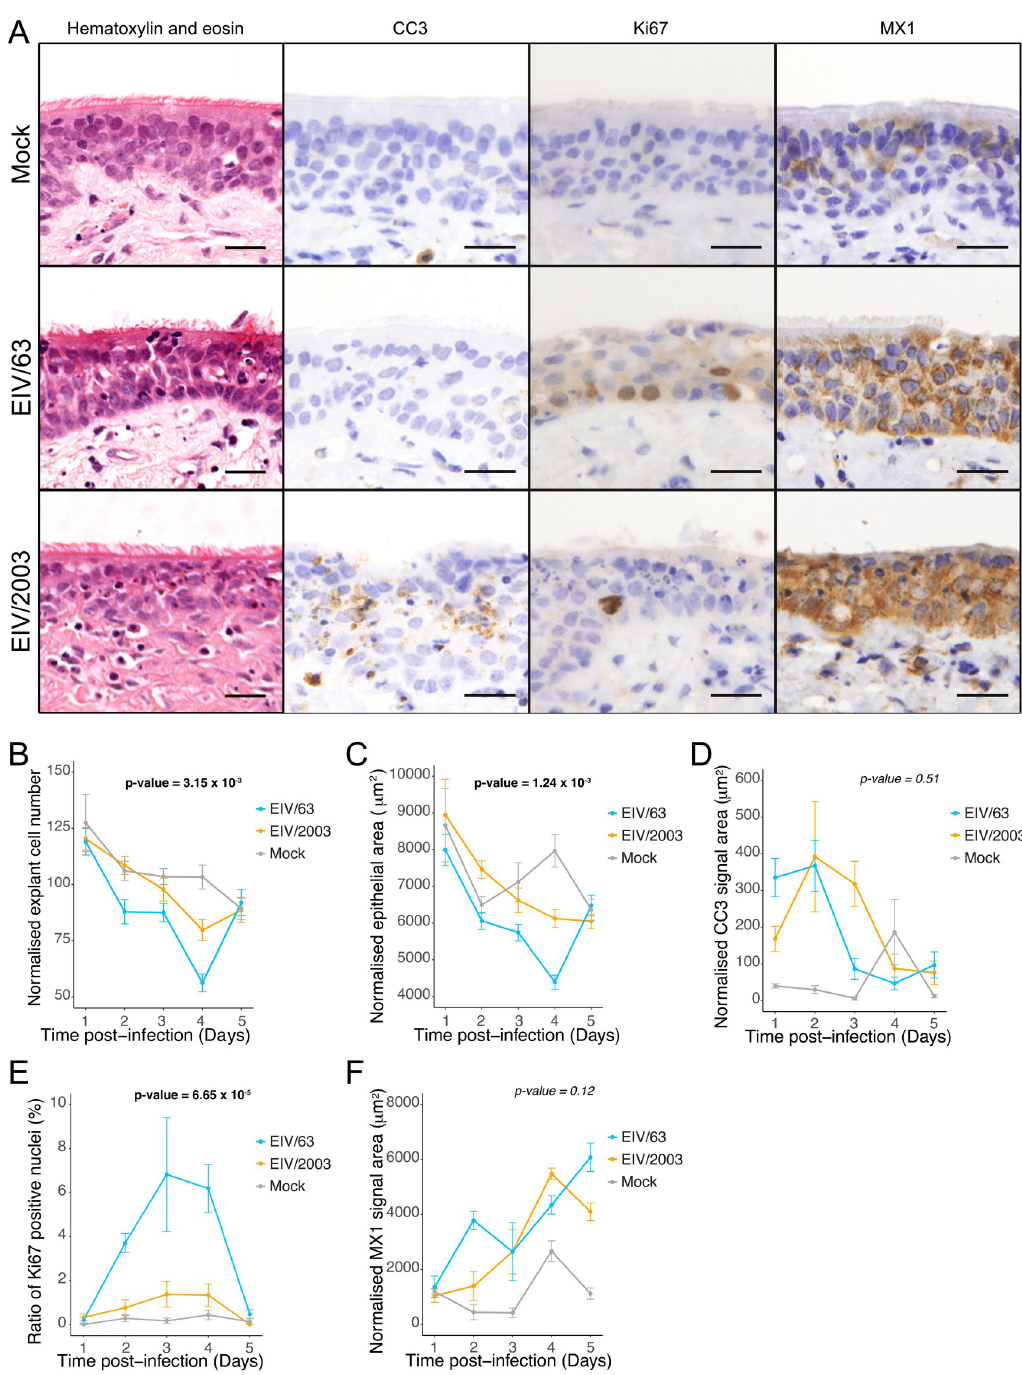
Fig 7. Analyses of morphological changes and cellular processes (apoptosis, viral spread, tissue regeneration, and innate immune response) in equine tracheal explants infected with either EIV/63, EIV/2003, or mock-infected. (A) Representative images of histological sections of explants infected with EIV/63, EIV/2003, or mock-infected at day 3 pi stained with haematoxylin and eosin (H&E), or immunostained (CC3, Ki67, MX1). (B-F) Plots showing measurements of the number of nuclei (B), epithelial area (C), cleaved-caspase 3 staining (D), Ki67 staining (E), and MX1 staining (F). Cyan, orange, and grey lines represent explants infected with EIV/63, EIV/2003 and mock-infected, respectively. Antigen quantifications are summarised as the mean ± SEM of three images per section per timepoint on three independent sections. P-values are shown in bold when significant and were calculated using generalized linear mixed-effects models.